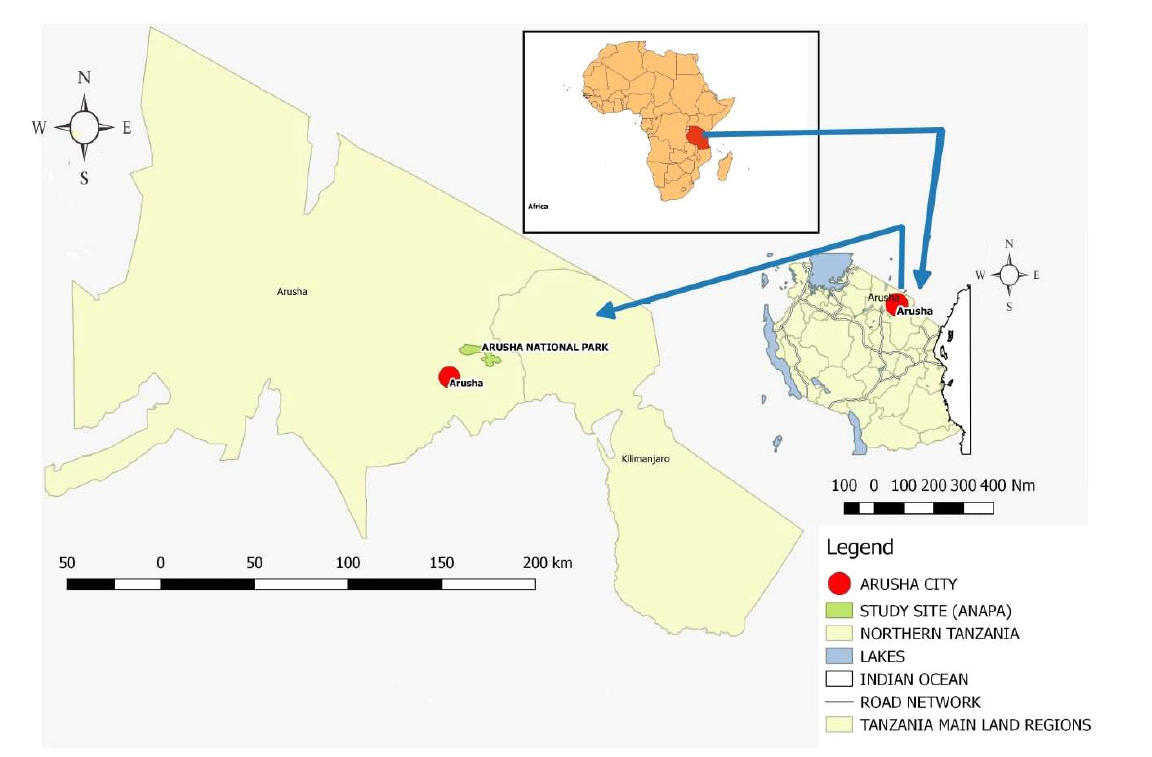
Fig. 1: ANAPA, Maps showing the location of Arusha National